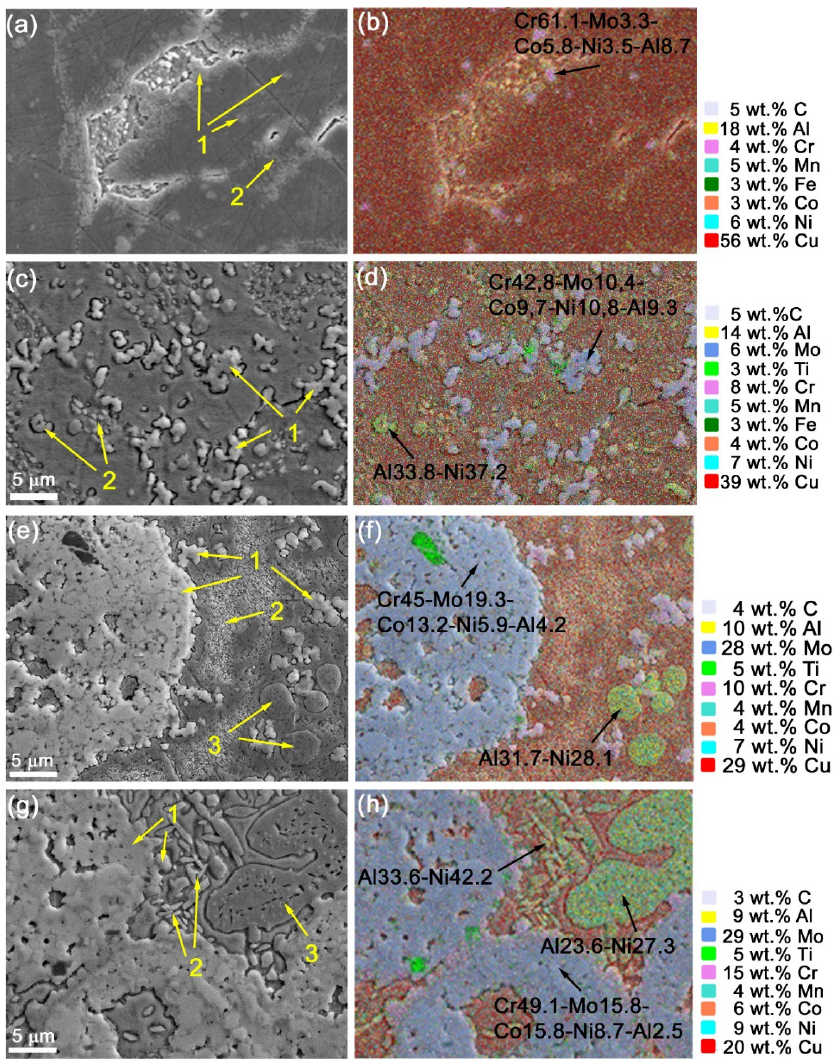
Figure 5. SEM images and EDS maps of the composite microstructures ( a , b ) 5% Ud; ( c , d ) 10% Ud; ( e , f ) 15% Ud; ( g , h ) 25% Ud. 1—Cr-rich particles; 2, 3—NiAl particles.